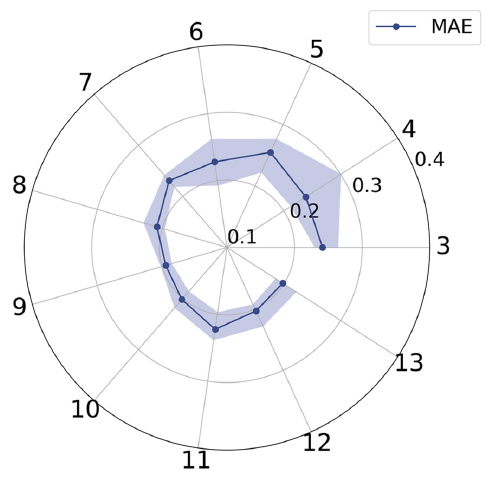
Figure 5. MAE values of the LSTM model with different sliding time window size. The solid lines represent the average value from ten repeated simulations and the upper and lower boundaries of the band represent the maximum and minimum from the ten simulations. Table 1. Basic information of model parameter tuning.